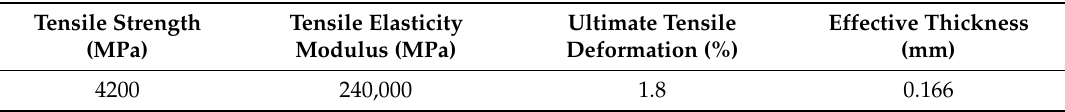
Table 3. Mechanical properties of CFRP